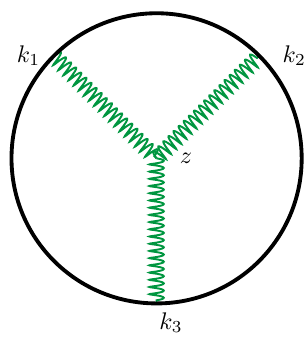
Figure 1 . The three point vector 1